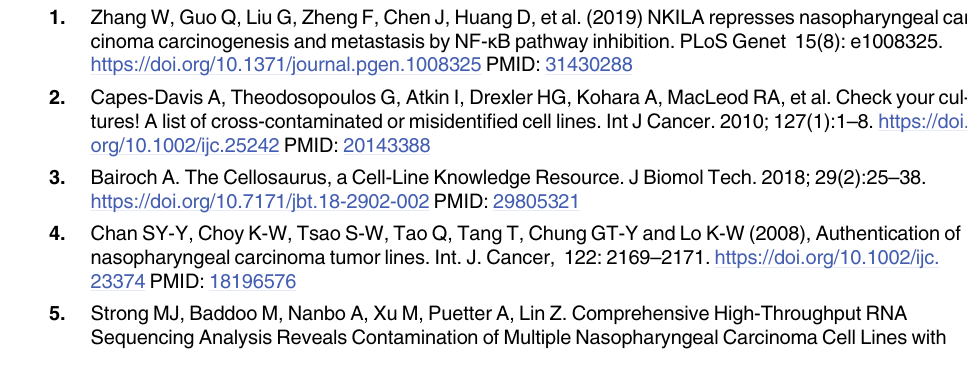
S5 File. Fig 6E replicate